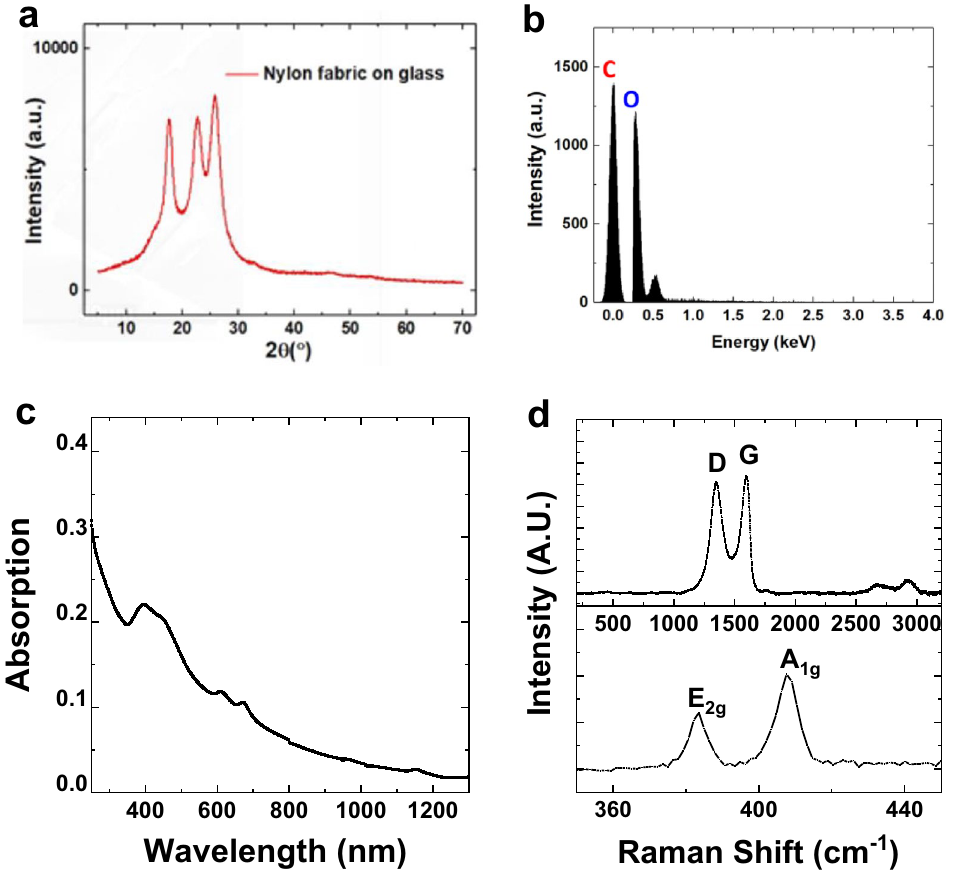
Figure 2. Characterisation of textile and electronic inks. ( a ) XRD of nylon fabric on glass substrate. ( b ) Energy Dispersive X-ray analysis of RGO-coated fabric. ( c ) UV–Vis of the MoS 2 ink with four absorption peaks. ( d ) Raman Spectroscopy of the MoS 2 ink and